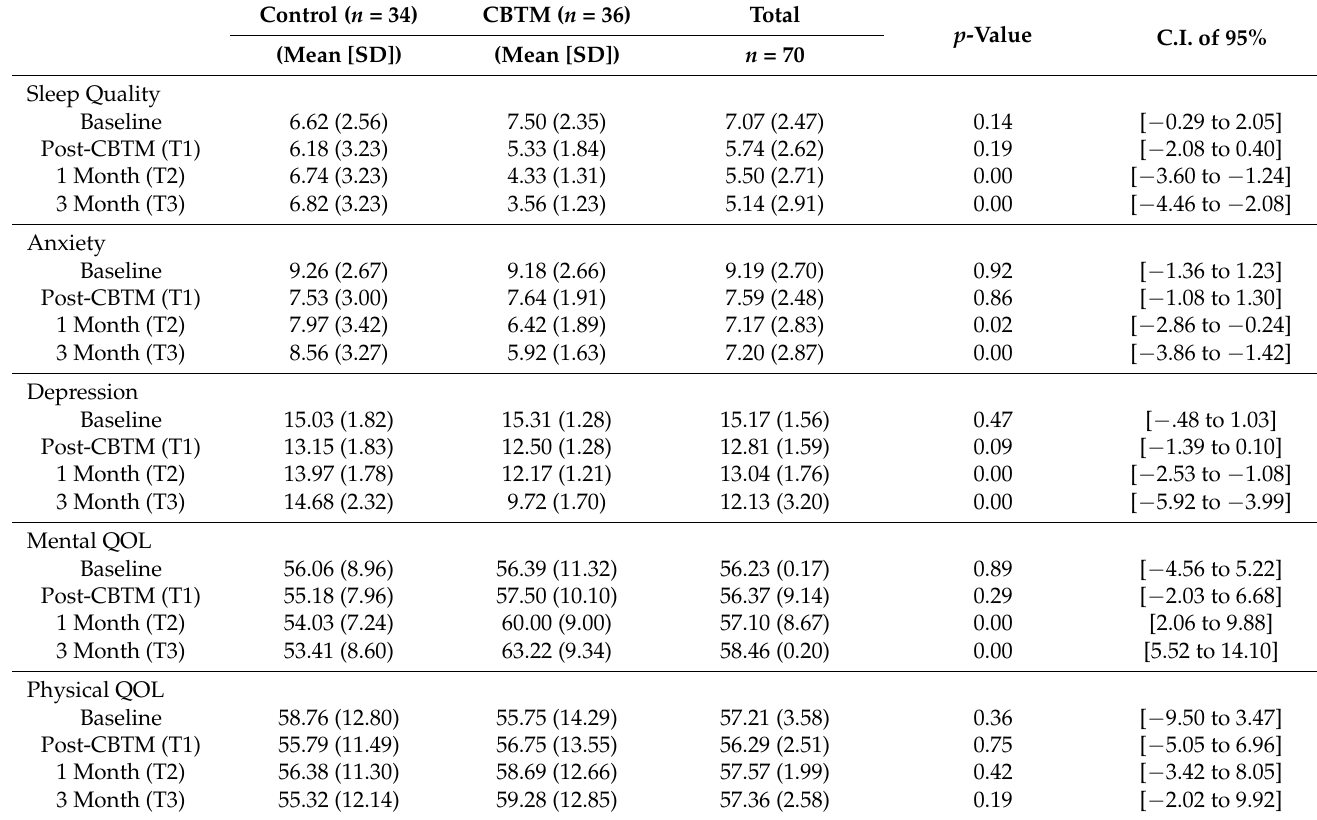
Table 2. Mean (SD) Differences from Baseline to Post CBTM, 1-Month & 3-Months Follow-up.